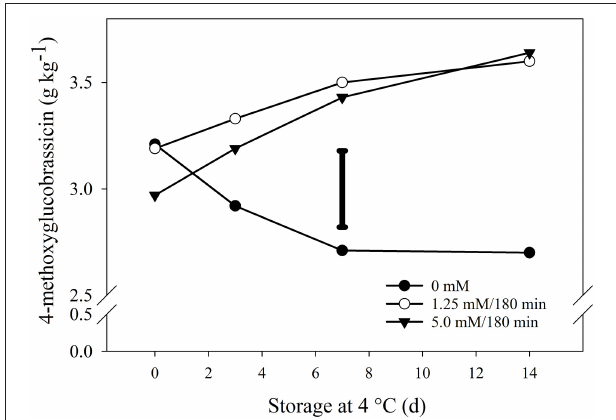
FIGURE 5 | Impact of hydrogen peroxide on 4-methoxyglucobrassicin. Broccoli florets were exposed to three doses of H 2 O 2 , 0mM (•), 1.25 mM/180min ( ) and 5 mM/180min ( H ) during storage in the dark for 14 d at ◦ 4 ◦ C. Values are g equivalents of sinigrin on a dry weight basis and represent the mean of 3 replicates per treatment ( n 3). The individual bar represents = the LSD value (0.05) 0.35. Sampling on day 0 was performed 6h after the = end of the treatments.